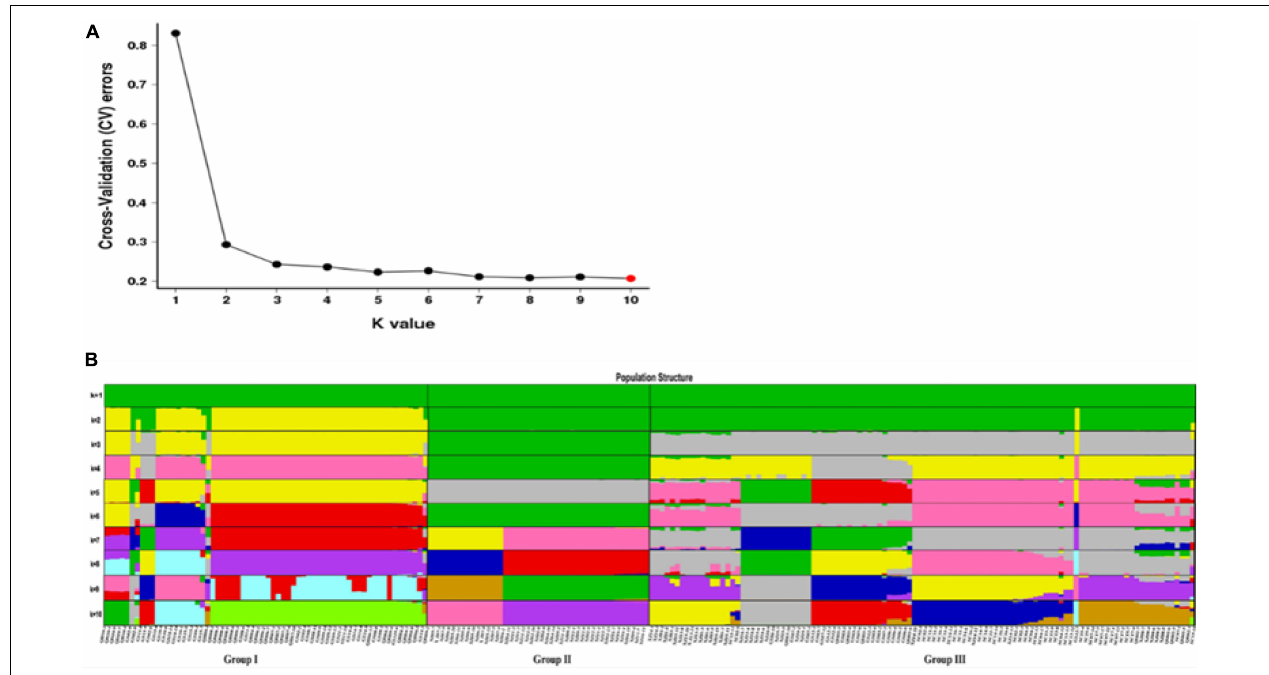
FIGURE 7 | (A) Admixture estimation of the number of groups for K values ranging from 1 to 10. (B) Population structure analysis of the 216 individuals based on 30,159,737 SNPs. The bars in the x -axis indicate different individuals. Colors in each row represent structural components.